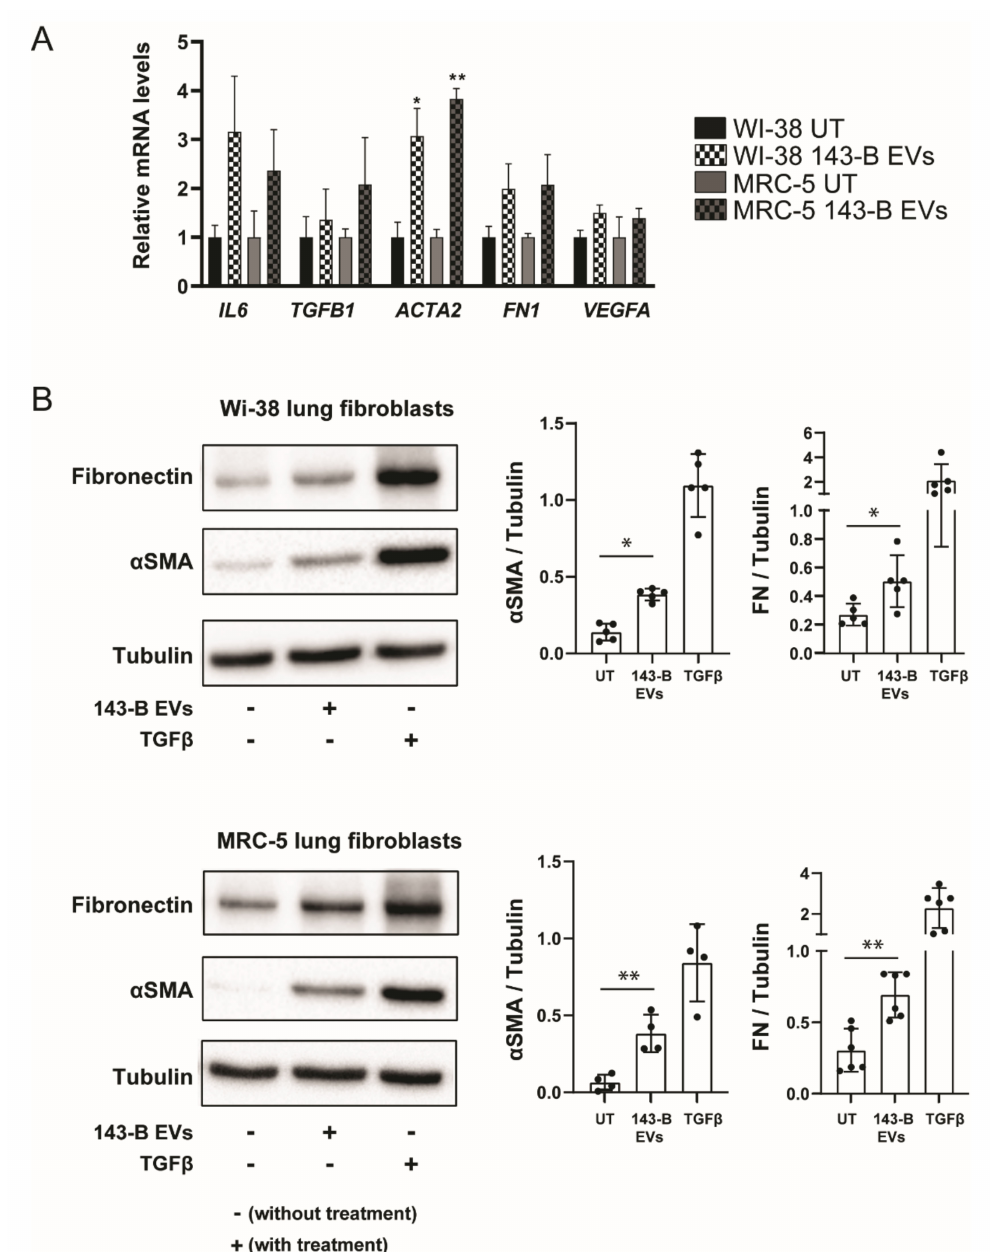
Figure 3. 143-B EVs induce lung fibroblast di ff erentiation in vitro. ( A ) Relative mRNA